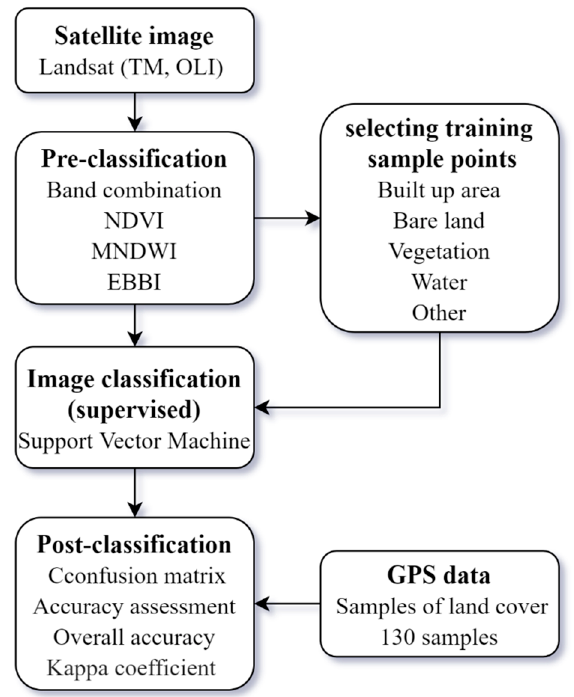
Table 2. Different types of land use/cover classes and related indices in the studied area.